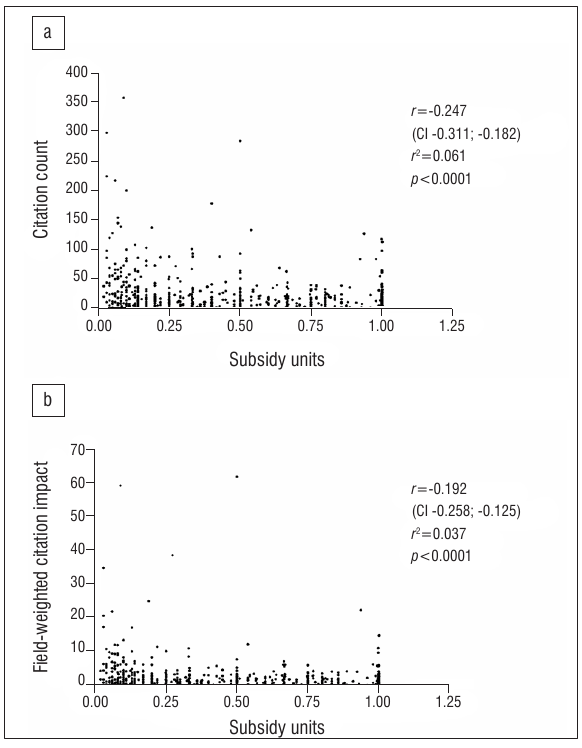
Figure 1: Correlation of the subsidy units assigned to the University of Cape Town for journal articles published by authors from the Faculty of Health Sciences in 2011 with (a) the citation count and (b) the field-weighted citation impact, for the period 2011–2015 (accessed 15 December